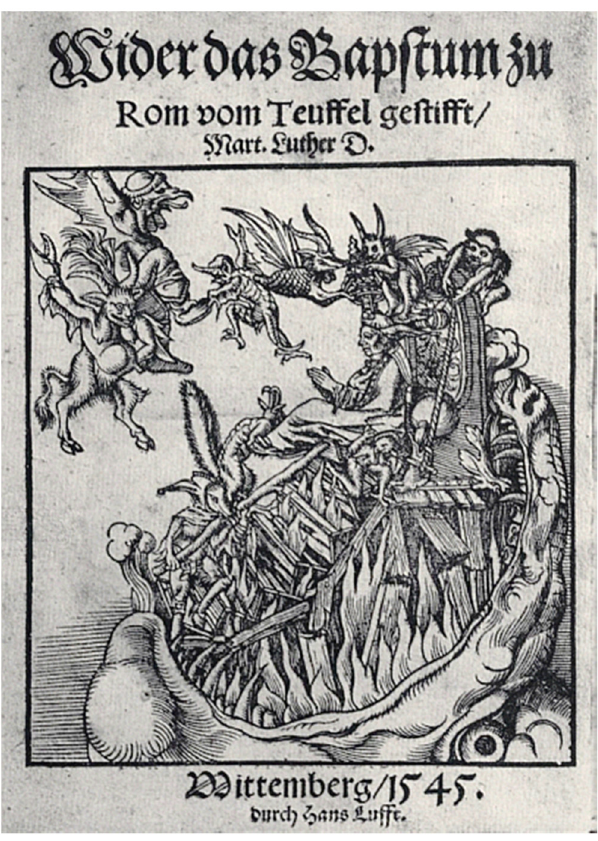
Figure 5: Martin Luther, Wider das Papstum zu Rom vom Teufel gestiftet , 1545. Wittenberg durch Hans Lu ff t. Cover after Lucas Cranach, 1545. Public